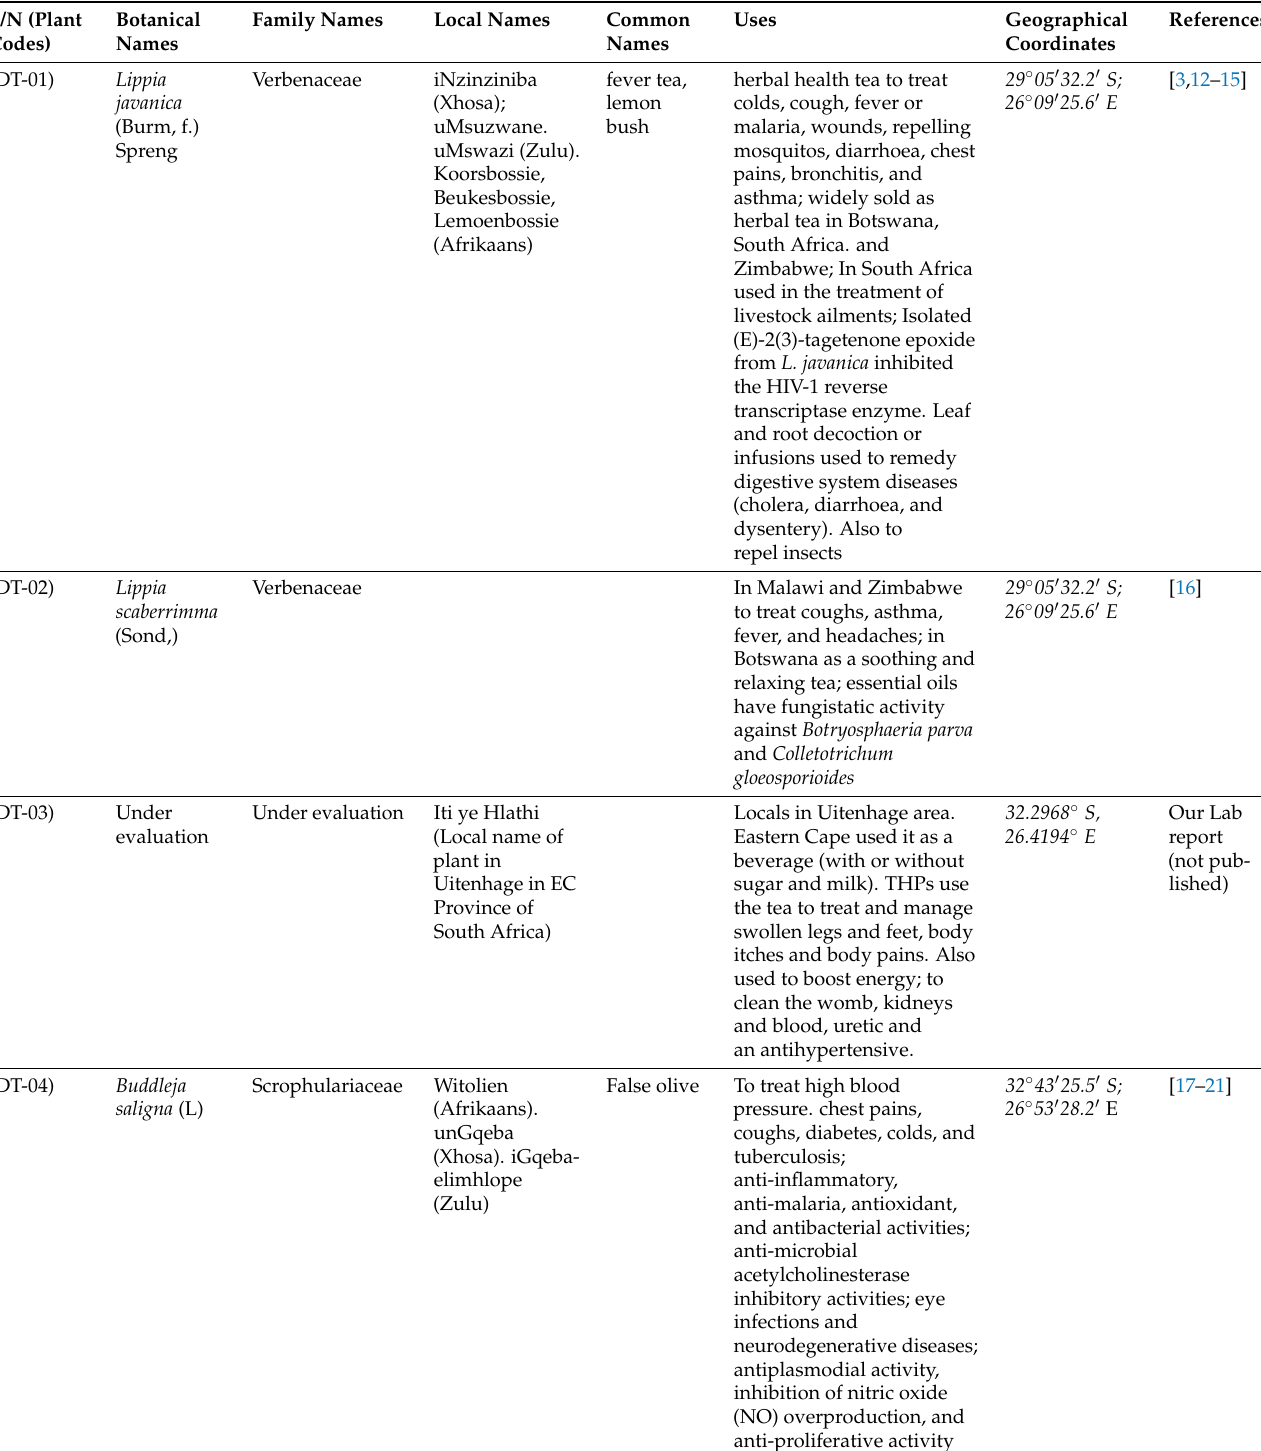
Table 1. Selected indigenous South African indigenous tea plants with their code names, botanical names, local names, uses and geographical